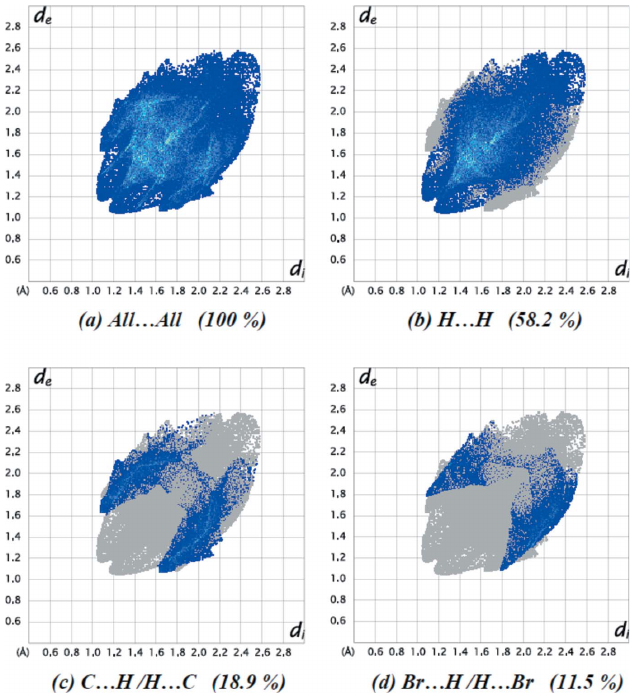
Figure 5 The two-dimensional fingerprint plots of the title compound, showing ( a ) all interactions, and delineated into ( b ) H (cid:3)(cid:3)(cid:3) H, ( c ) C (cid:3)(cid:3)(cid:3) H/H (cid:3)(cid:3)(cid:3) C and ( d ) Br (cid:3)(cid:3)(cid:3) H/H (cid:3)(cid:3)(cid:3) Br interactions. [ d e and d i represent the distances from a point on the Hirshfeld surface to the nearest atoms outside (external) and inside (internal) the surface, respectively.]